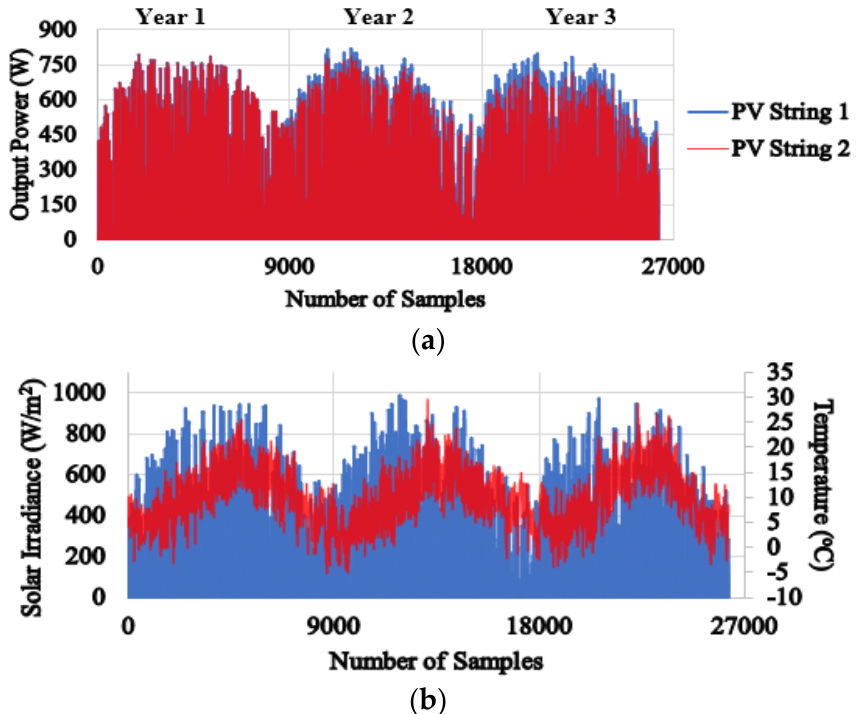
Figure 7. PV and metrological data of the PV system: ( a ) PV strings measured output power taken from the inverters log (MPPT data log), ( b ) Solar irradiance and PV surface temperature. The boxplot in Figure 8b provides the output mean values of the yearly PR. The lowest PR for the first PV string, 90.5%, was discovered during its first year of operation. This result was expected [21–24] because the PV modules were exposed for the first time to UV light and fluctuations in the solar irradiance and ambient temperature. However, the PR remained at high percentages in subsequent years; 92.1% and 91.6% during the second and third years of operation, respectively. In contrast, the second PV string had a lower PR ratio compared with the first PV string. During its first year of operation, the PR was 89.5% (1% less than the first PV string). In contrast, the PR ratio decayed in the subsequent years; 87.3% and 86.6% during the second and third years of operation, respectively. This result suggests that cracks, early stage PID, and EVA degradation started to develop in the second PV string during the second to third years of